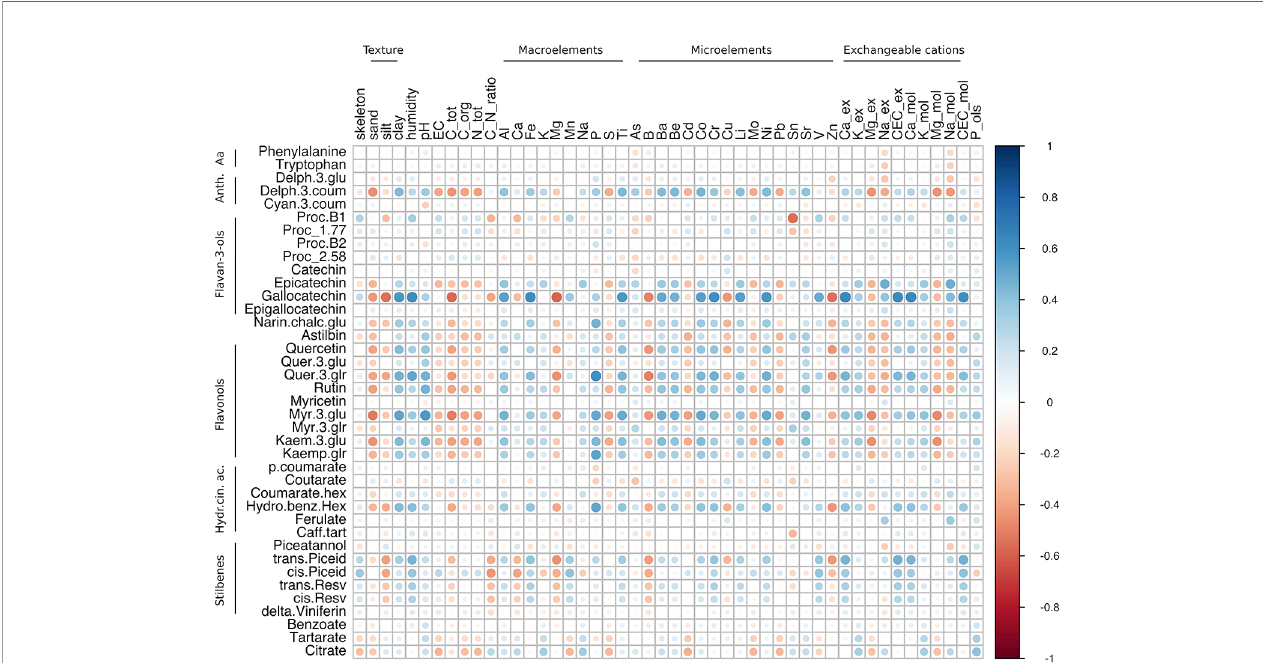
FIGURE 7 | Correlation analysis of grape skin secondary metabolites of both cv. Corvina and cv. Glera at harvest against the physico-chemical characteristics of the soil. The analysis was limited to 39 shared metabolites out of 51. Most of the anthocyanins were excluded from the analysis since they accumulated exclusively in Corvina. The analysis was generated using Pearson's correlation.